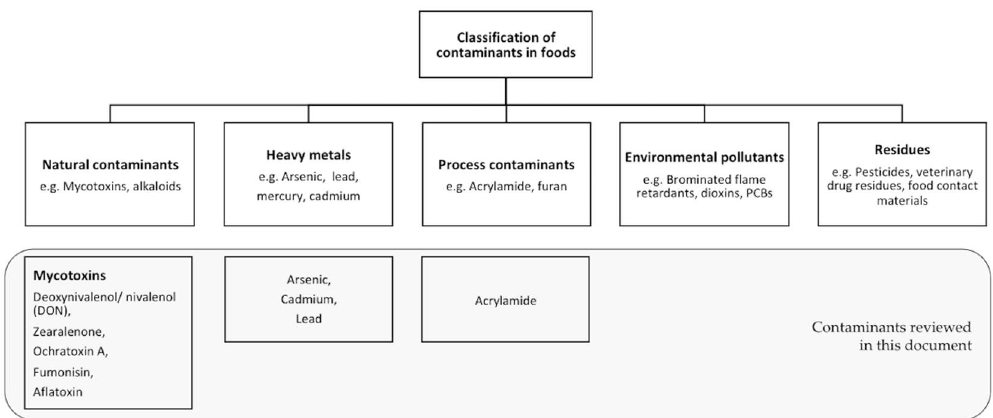
Figure 1. Classification of contaminants in